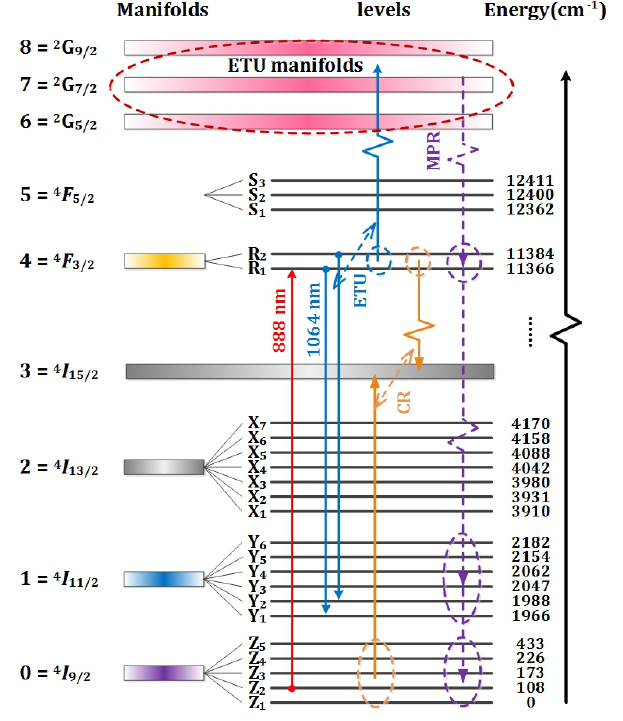
Figure 1. Energy sublevels and main transitions of Nd 3 + ions doped in YVO 4